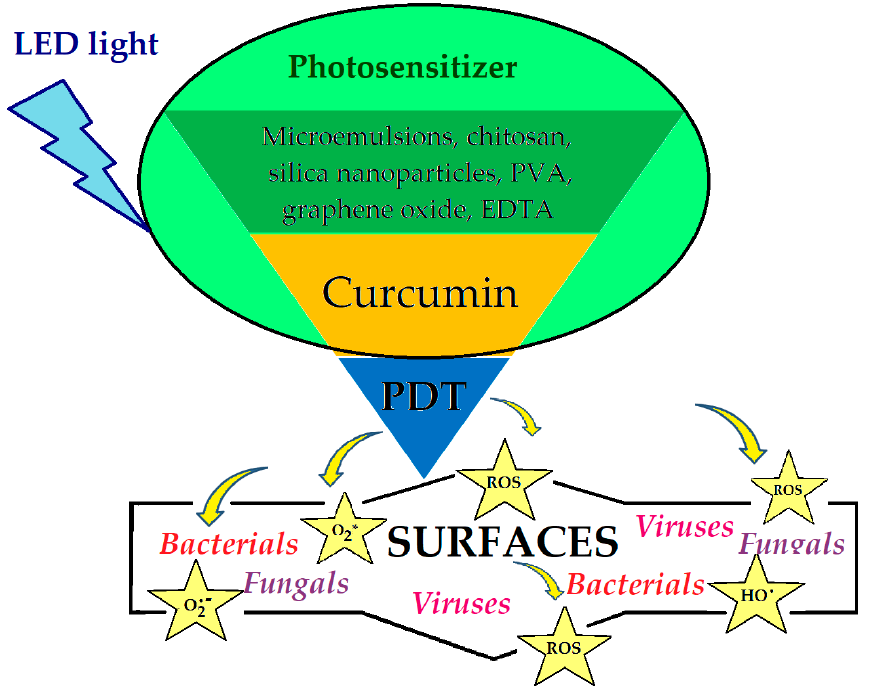
Figure 4. Types of curcumin encapsulations used as a sensitizer in antimicrobial photodynamic therapy (aPDT).